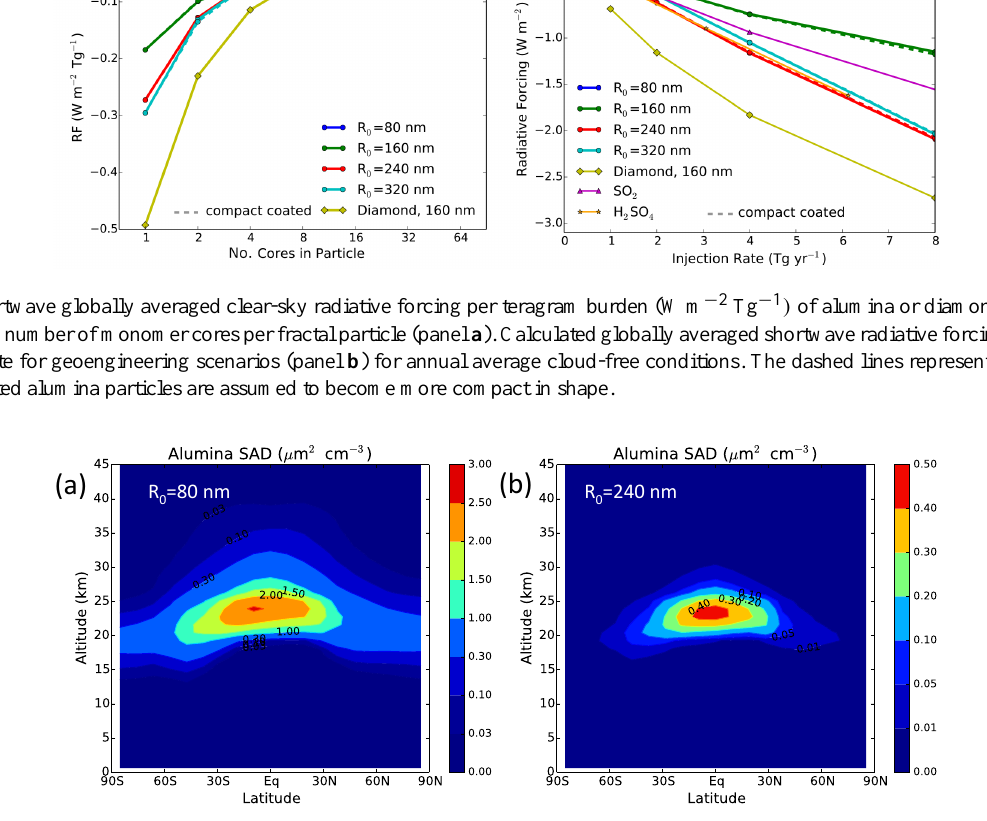
Figure 8. Calculated annual average surface area density (µm 2 cm − 3 ) of uncoated alumina particles due to geoengineering with 1Tgyr − 1 injection of (a) 80nm alumina monomers and (b) 240nm alumina